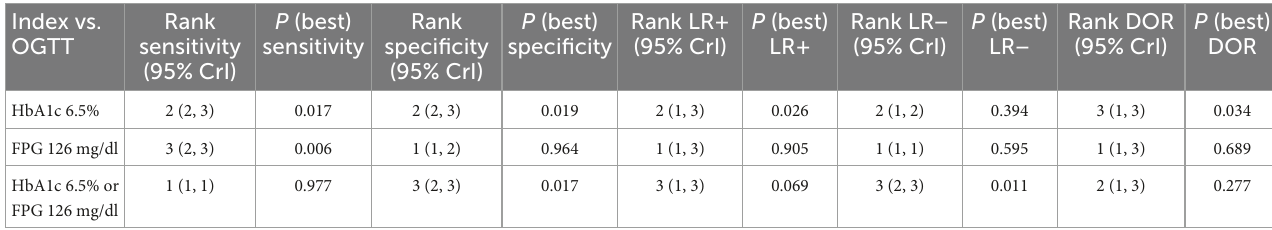
TABLE 2 The relative ranking of index